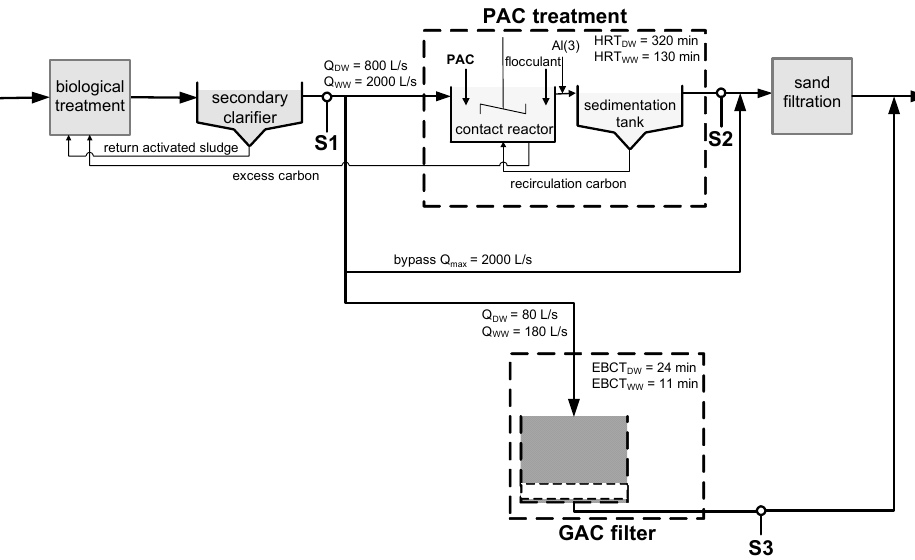
Figure 1. Flow chart of WWTP Mannheim and sampling points (S1, S2 and S3).